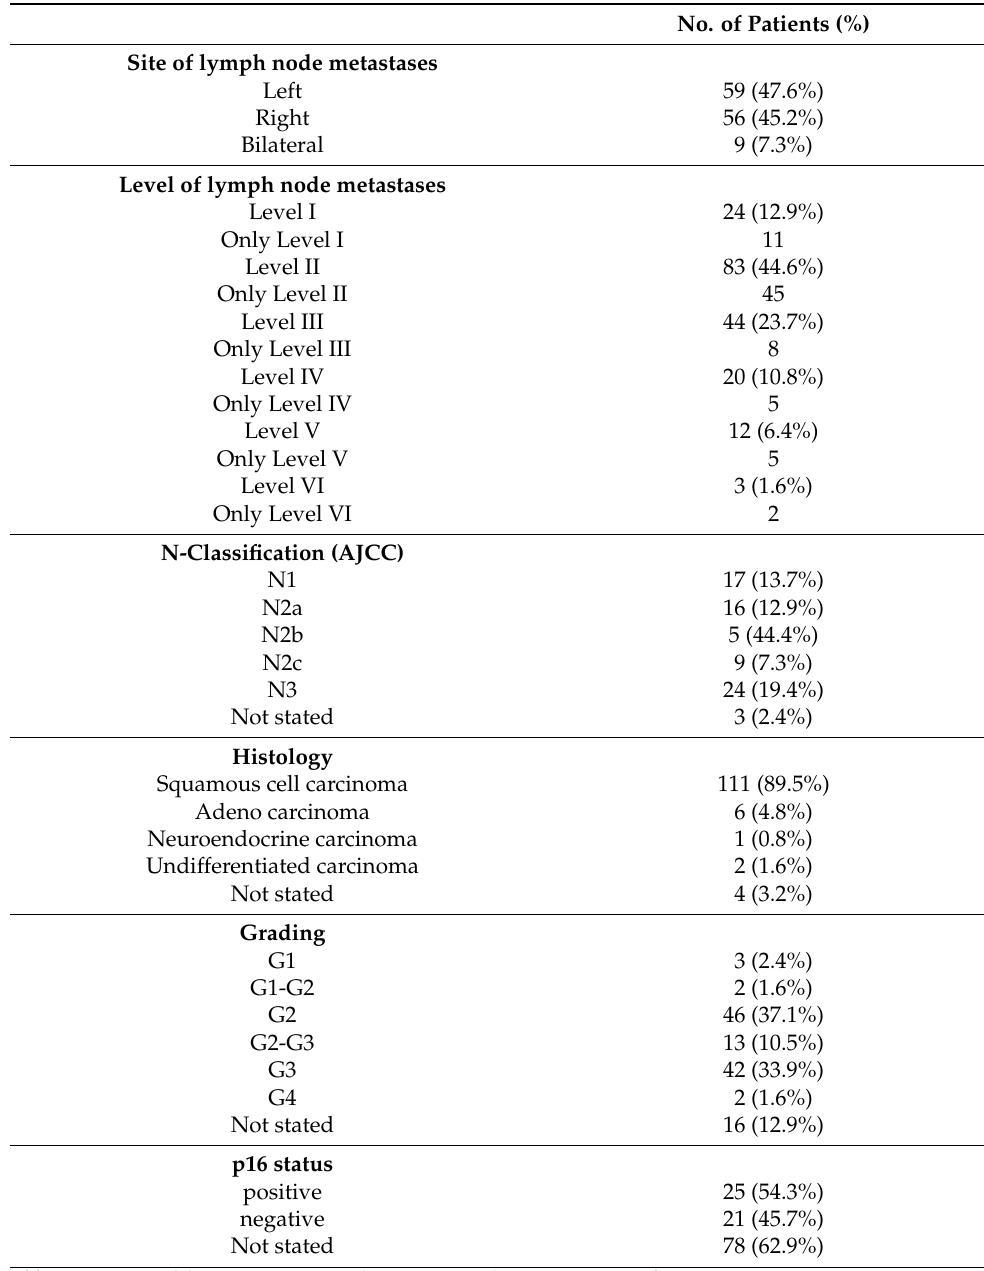
Table 2. Details of lymph node